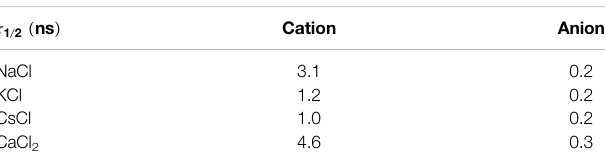
TABLE2| Residencehalf-lifetime( τ 1 / 2 )(ns)calculatedfromthesurvivalprobability [P( τ )] evolution for cations and anions in each simulation ( Supplementary Figure 9 ).